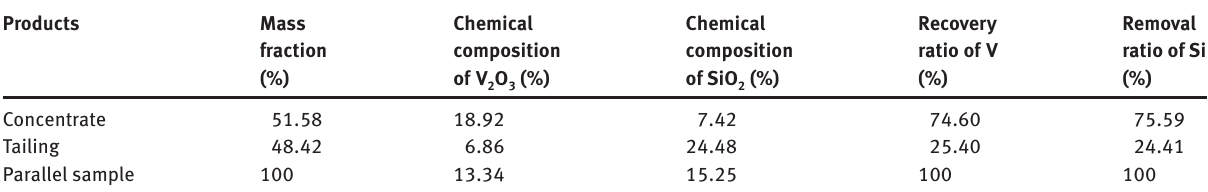
Table 6: Recovery ratio of V and removal ratio of Si in the concentrating products Products